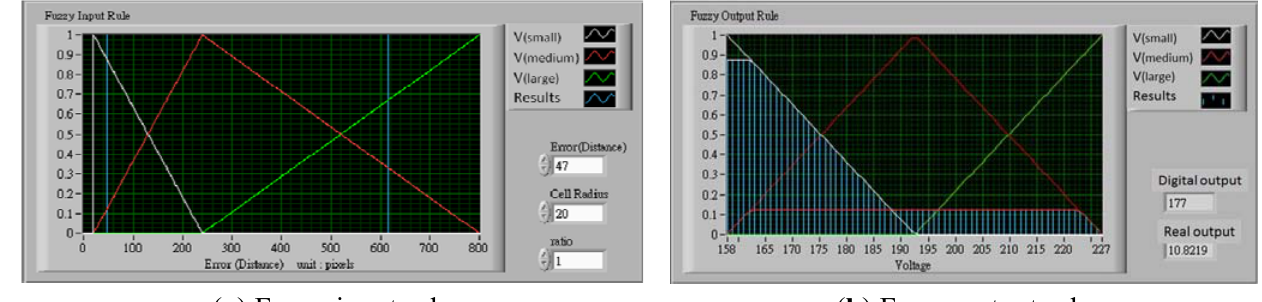
Figure 10. The fuzzy output rule in this control